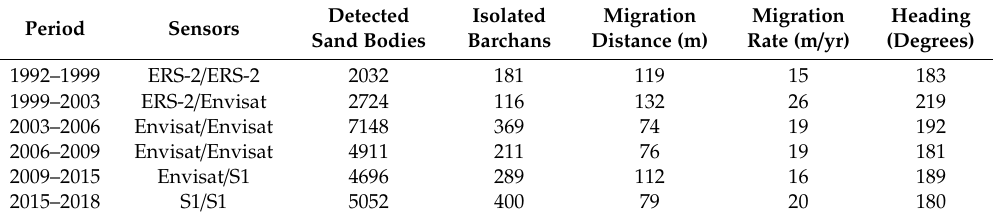
Table 3. Detected sand bodies, and average distance, velocity and heading of the isolated barchan dunes obtained, applying the dune area consistency criterion obtained from the West Sahara-Mauritania dune